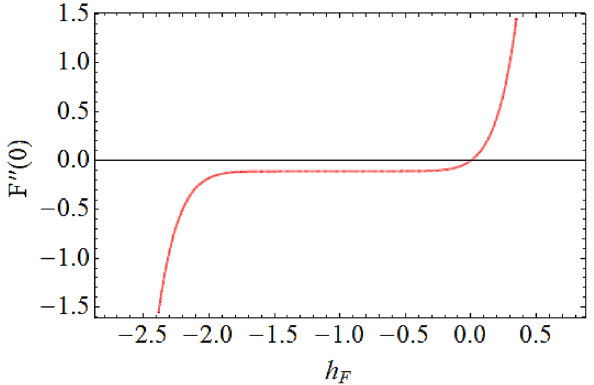
Figure 2. h curve for velocity field.